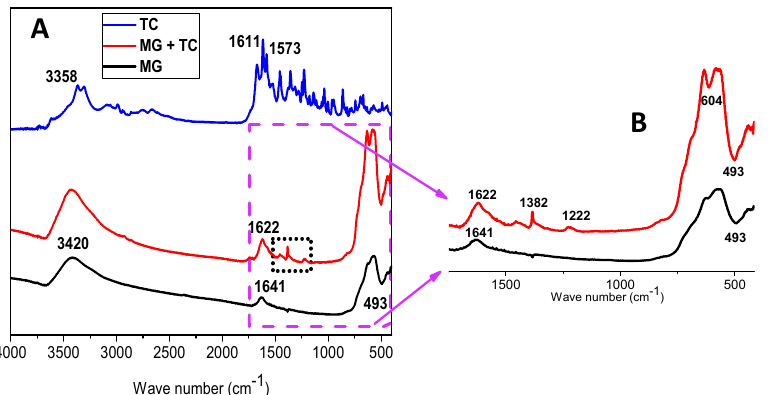
Figure 6. The FTIR spectra of maghemite before and after adsorption of tetracycline (4000–400 cm − 1 ) ( A ), and Enlarged portion of the maghemite spectra before and after adsorption of tetracycline (2000–400 cm − 1 ) ( B ).